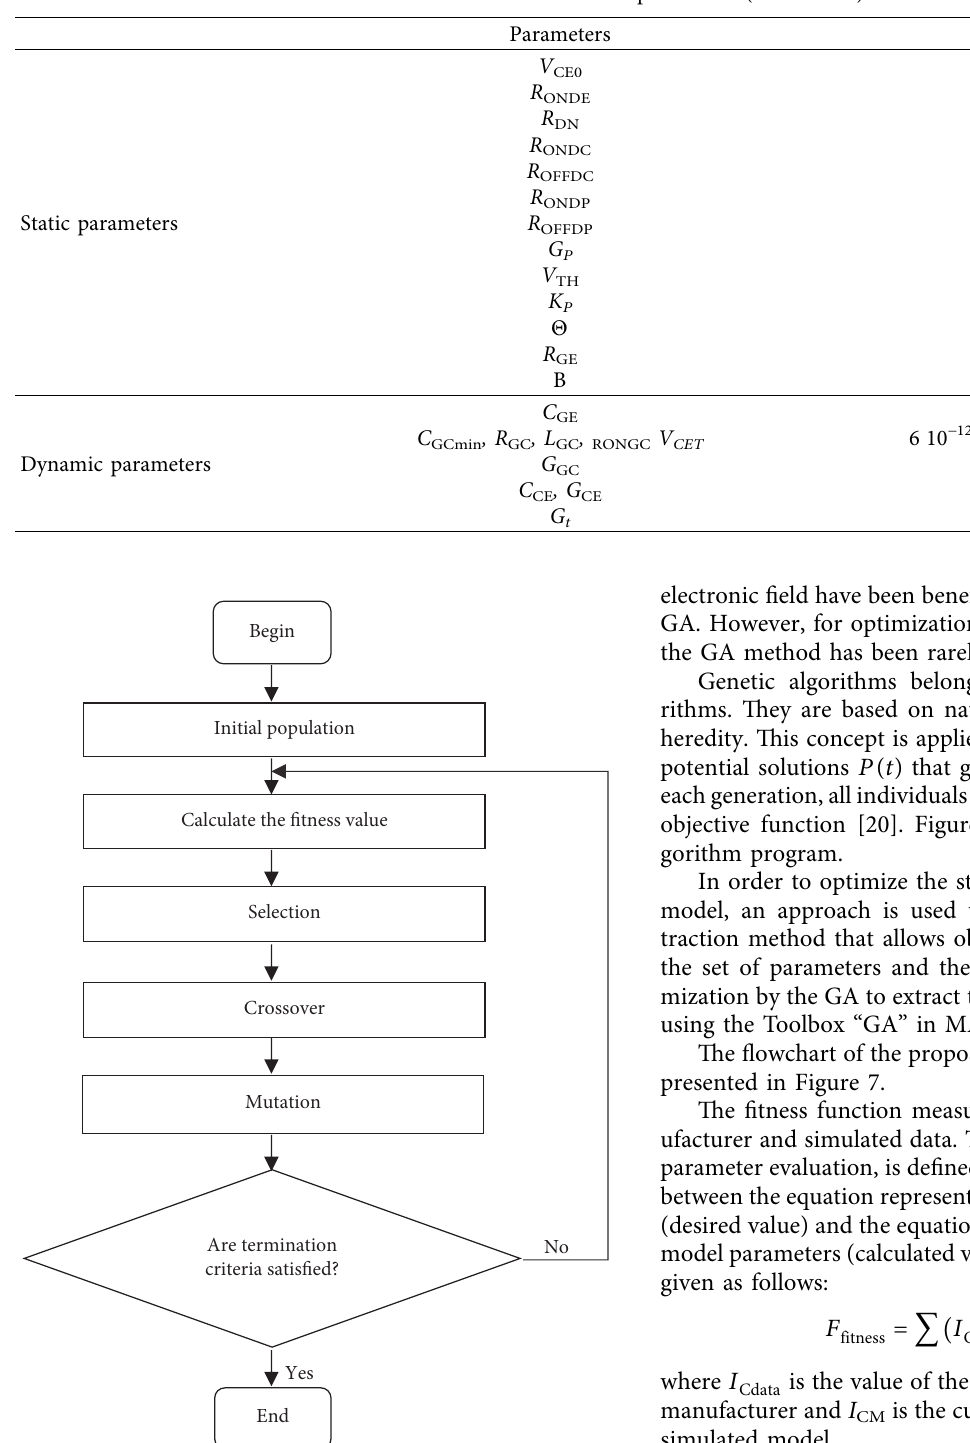
Figure 5: Flowchart of the standard genetic algorithm (GA).